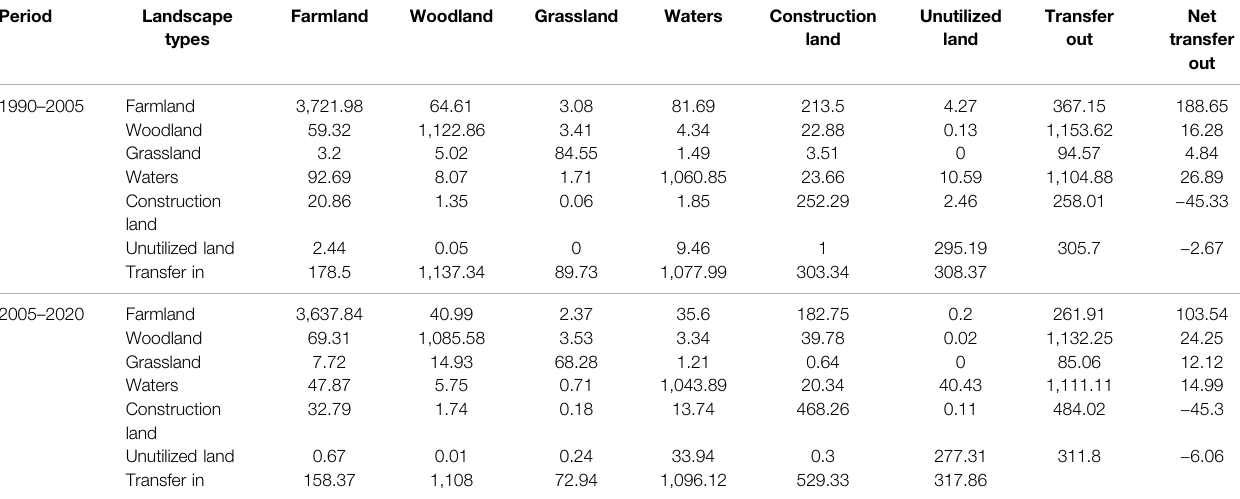
TABLE 6 | Land-use transfer matrix of the study area.